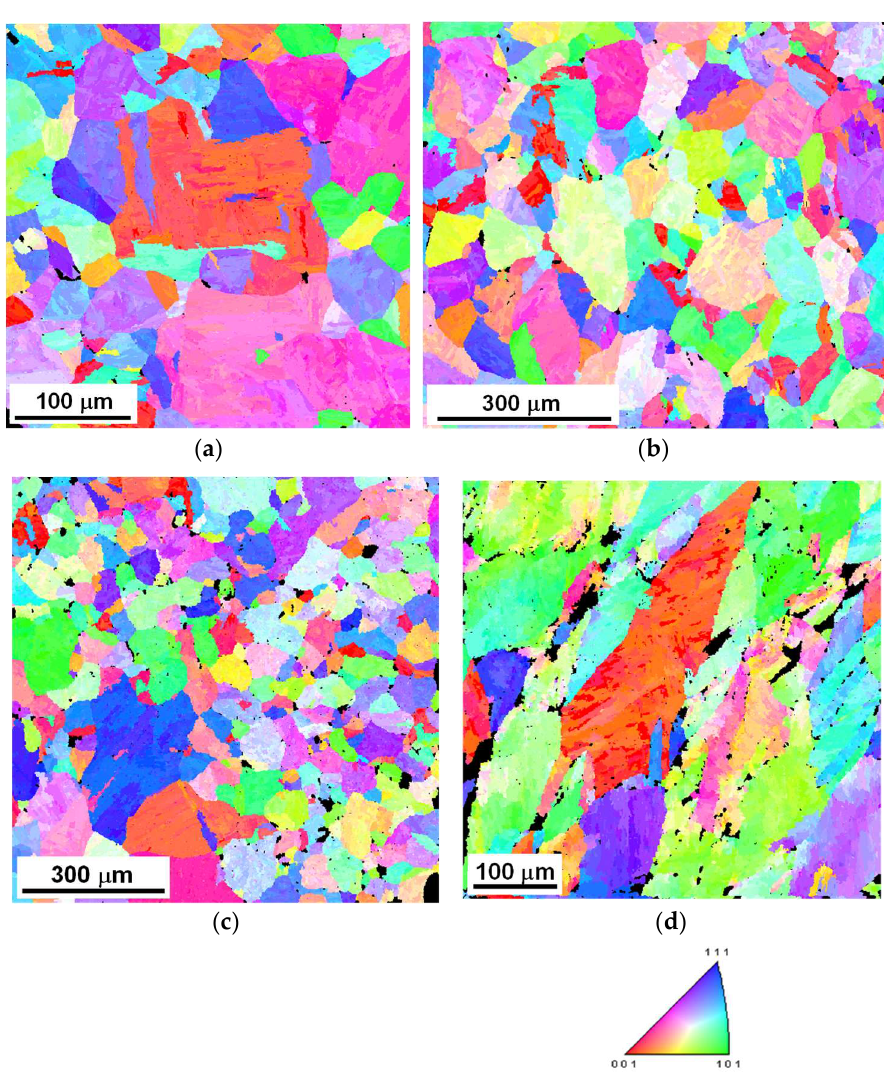
Figure 6 . IPF (Inverse pole figure) austenite ND orientation maps obtained from the reconstruction results applied to the martensitic scan data. Black areas represent non-reconstructed regions. ( a ) Recrystallized microstructure, step size = 0.5 μm, 99.5% reconstructed; ( b ) recrystallized microstructure, step size = 1 μm, 99.5% reconstructed; ( c ) recrystallized microstructure, step size = 1.5 μm, 97.8% reconstructed; and ( d ) deformed microstructure, step size = 1 μm, 95.1% reconstructed.